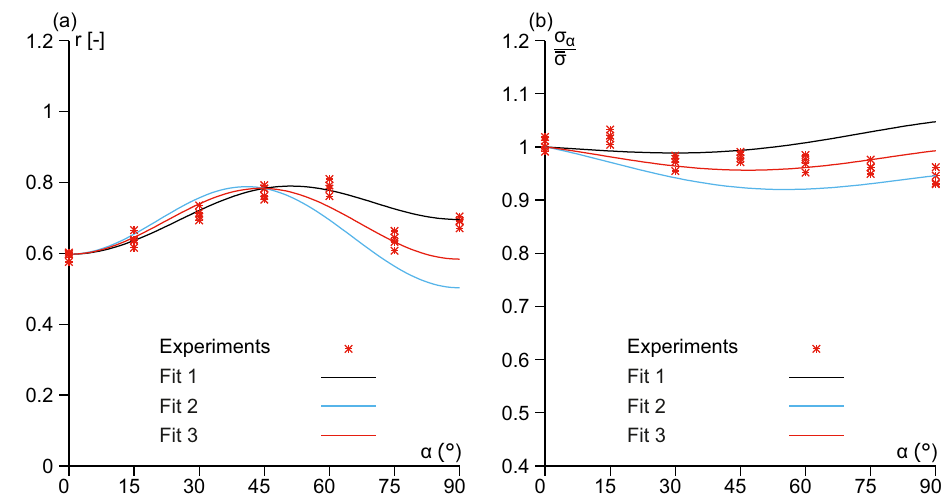
Figure 3. Experimental and numerically predicted ( a ) r values and ( b ) yield stresses.